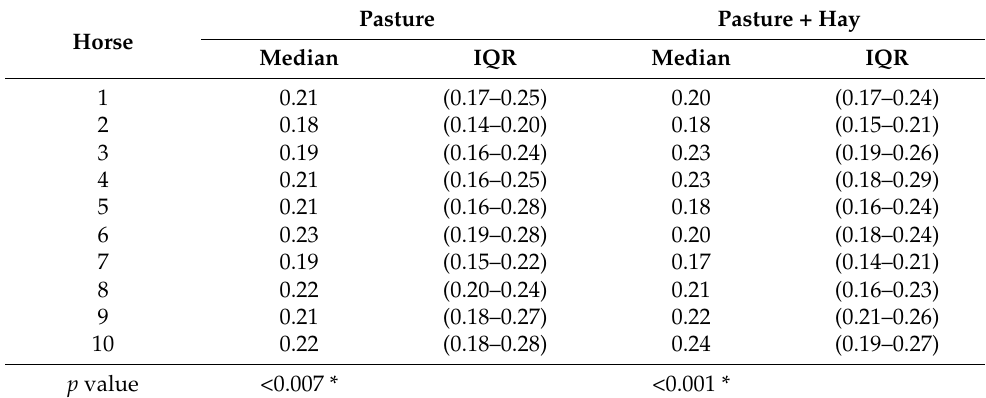
Table 4. Comparison of Bray-Curtis dissimilarity indices between the horses within each diet period. Pasture Horse